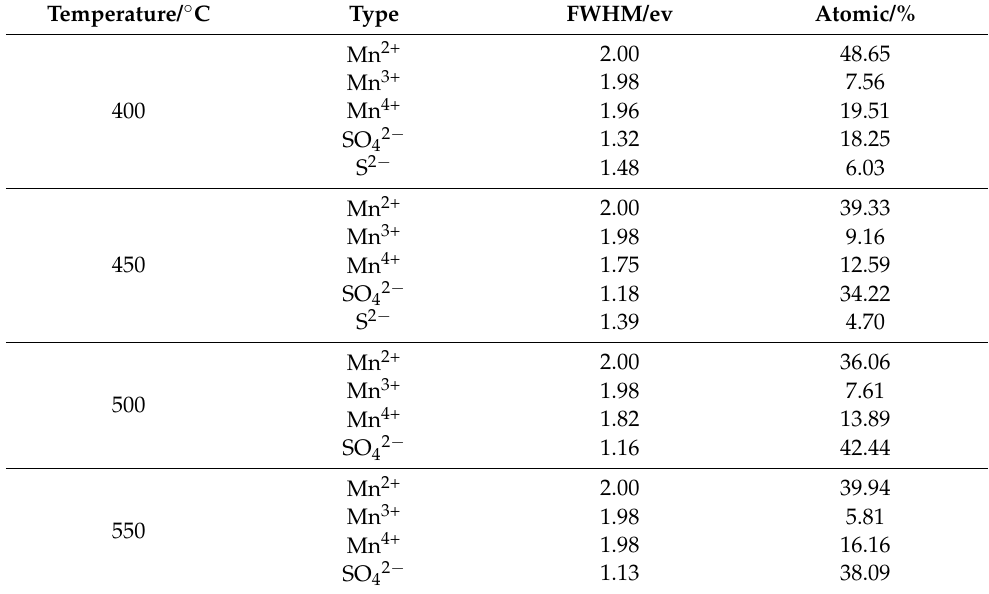
Table 3. XPS fitting parameters for Mn 2p and S